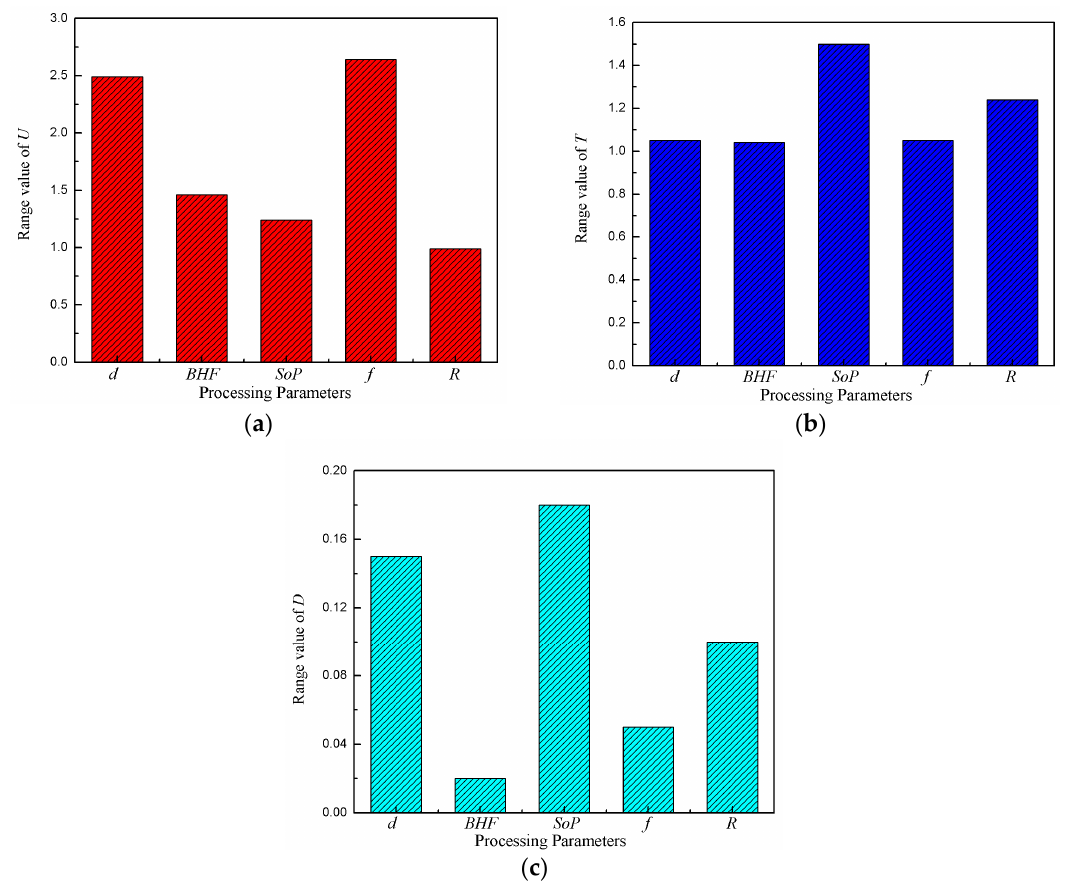
Figure 10. Range value of U , T , D under different factors: ( a ) range value of U ; ( b ) range value of T ; ( c ) range value of D .